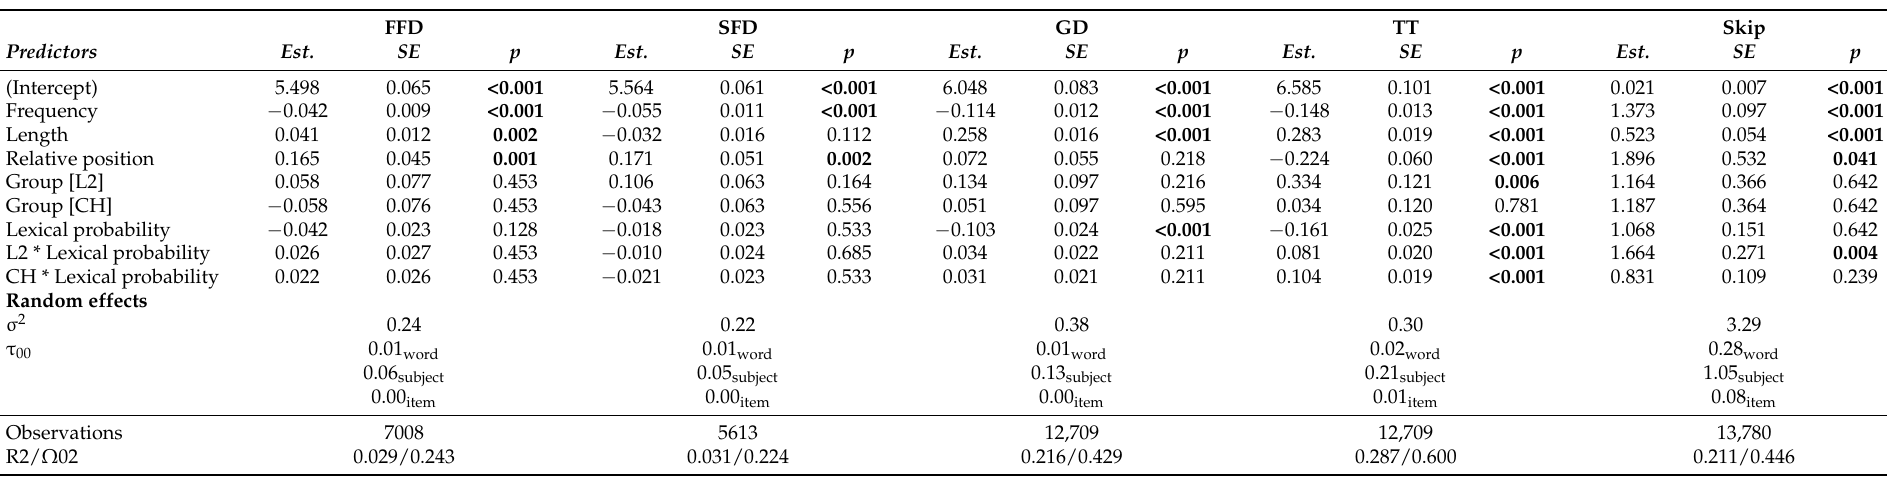
Table 4. The (g)LMMs summary for the lexical probability (HSs is the reference group). Significant effects are highlighted in